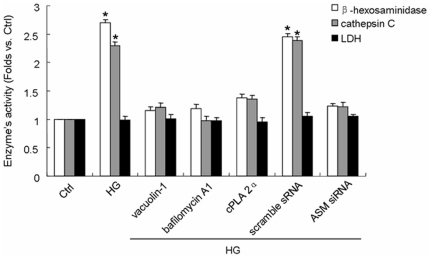
Effect of HG incubation with or without lysosomal inhibition or ASM gene silencing on the activity of β-hexosaminidase,cathepsin C or lactate dehydrogenase (LDH) in cultural medium.After incubation by normal glucose (Ctrl) or high glucose for 12 h (HG), the cultural medium was collected and the cells were lysed. The activity of β-hexosaminidase, cathepsin C and lactate dehydrogenase (LDH) were measured and the proportion of them in medium was calculated. Values are means±SE; n = 5 batches of cells. * P<0.05 vs. Ctrl.